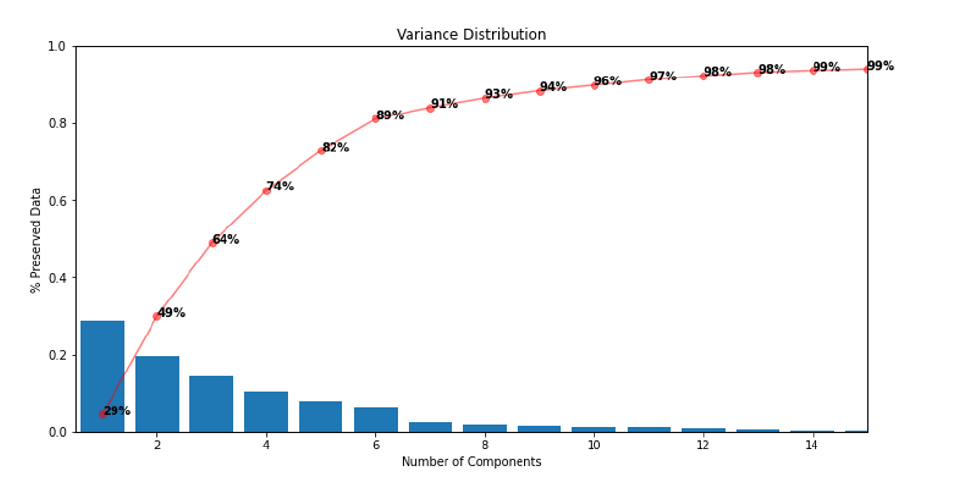
Figure 5. Pareto chart with the percentage of information for each PC.